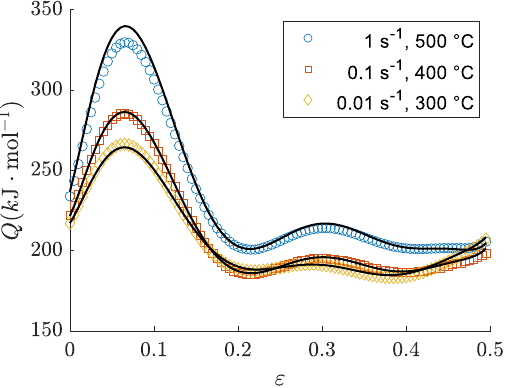
Figure 10. The obtained activation energies as Q ( ε , ˙ ε , T ) using method 2 for three randomly selected sets of strain rate and